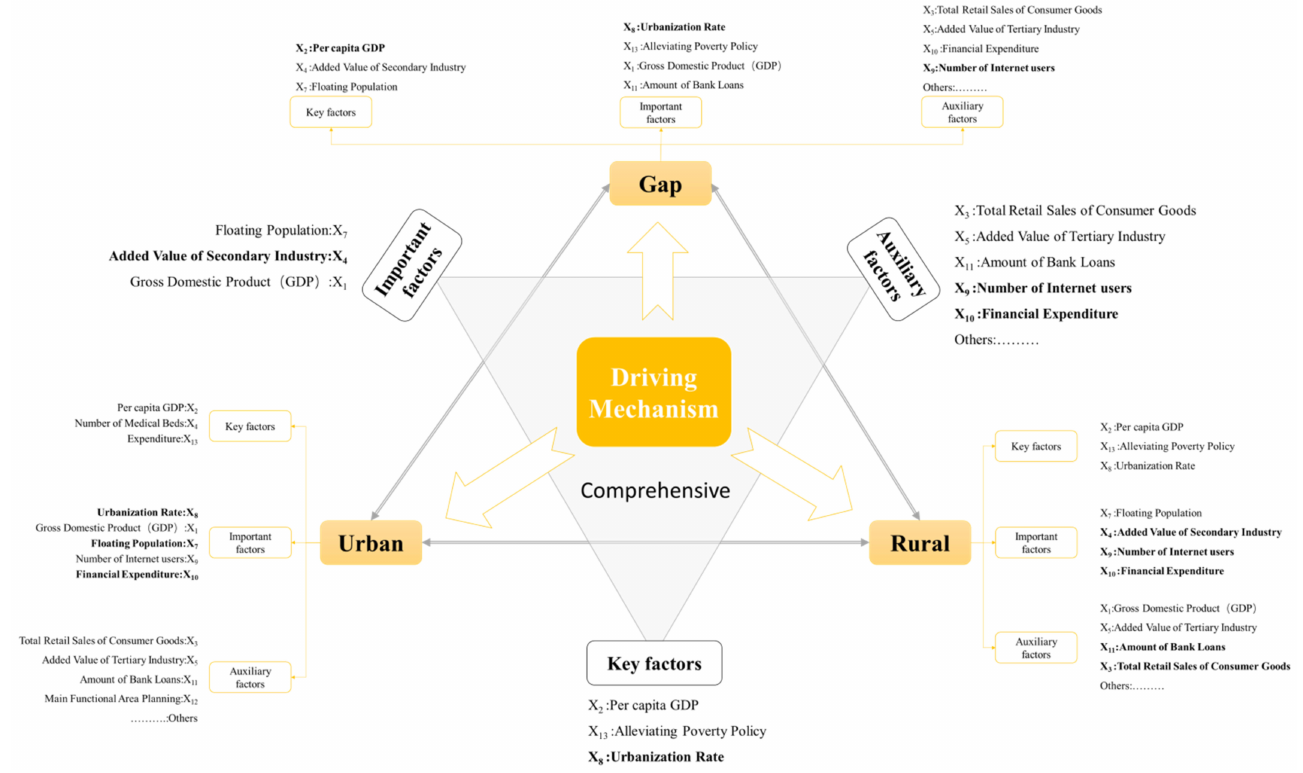
Figure 13. Driving mechanisms of urban–rural income